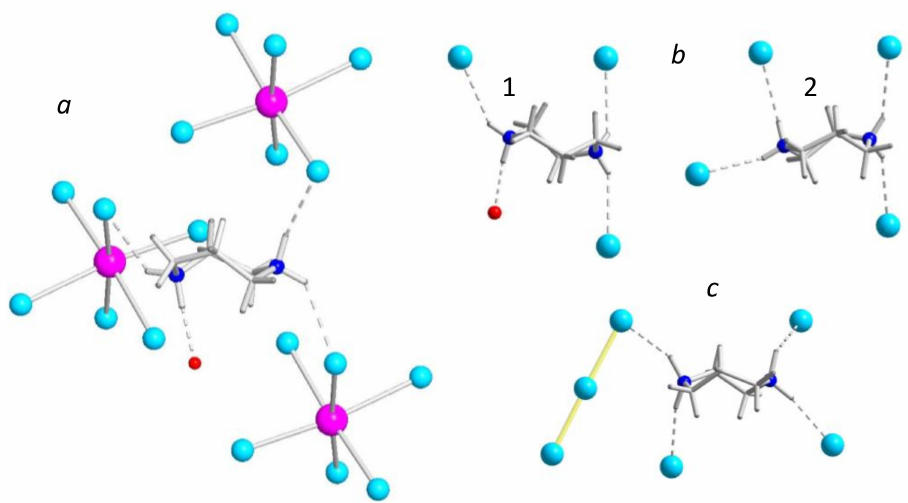
Figure 4. The surroundings of HpipeH 22 + cations in the crystal structures of (HpipeH 2 ) 2 Bi 2 I 10 · 2H 2 O ( a ), (HpipeH 2 ) 3 I 6 · H 2 O ( b ), and (HpipeH 2 )I(I 3 ) ( c ). Bismuth, magenta; iodine, cyan; oxygen, red; nitrogen, blue; carbon, light gray, hydrogen, dark gray. Hydrogen (N)H ··· O and (N)H ··· I bonds are shown as dashed lines. Note that the surrounding of HpipeH 22 + cations in the crystal structure of (HpipeH 2 ) 3 (H 3 O)I 7 is the same as in (HpipeH 2 ) 3 I 6 · H 2 O, type 2 (b).